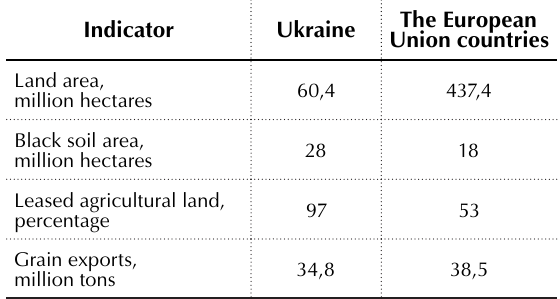
Table 2. Agricultural land use